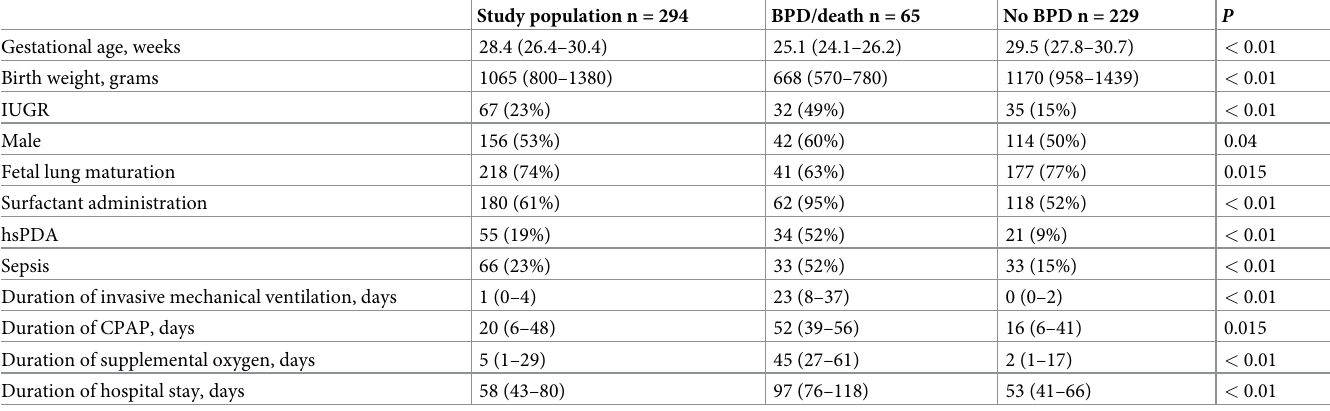
Table 1. Characteristics of the study population and comparison to infants with BPD/death and those without BPD.